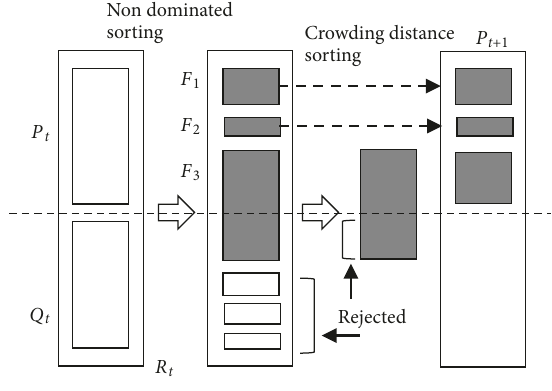
Figure 2: NSGA-II procedure